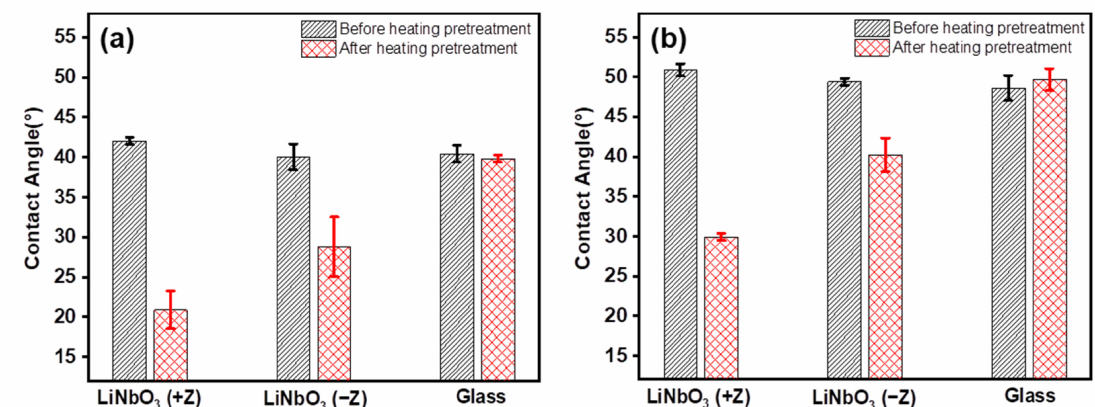
Figure 1. Contact angle of the ionic liquids (ILs) on the LiNbO 3 and glass substrates before and after the heating pretreatment. ( a ) [EMIM][NTf 2 ], ( b ) [EMIM][BF 4